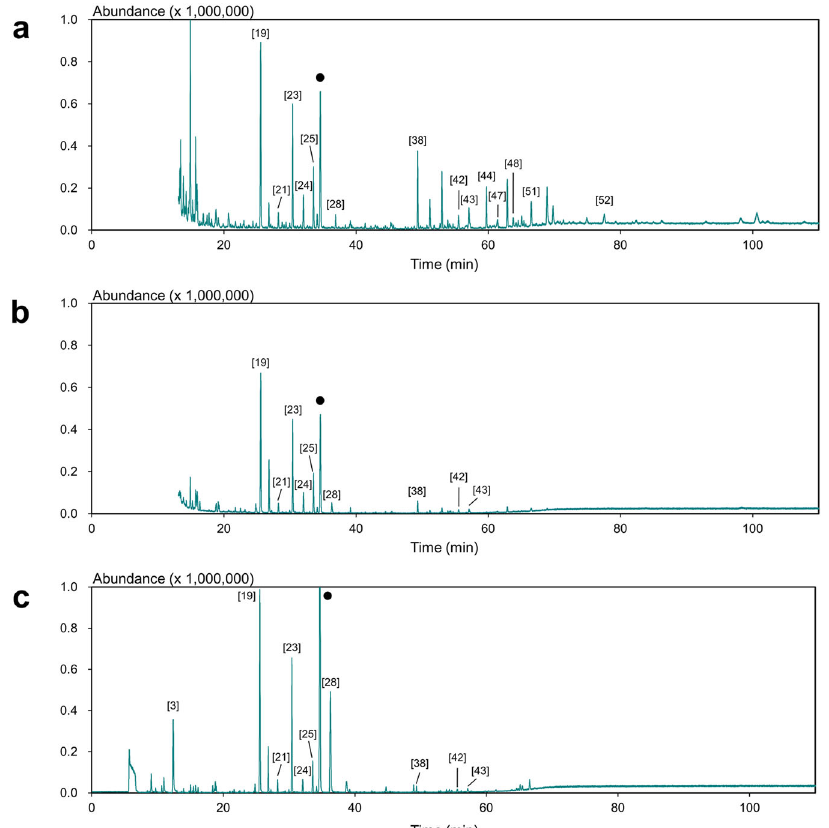
Fig. 2 GC – MS chromatograms of the EVOO extracts obtained using each extraction method. The chromatograms for OA-LLE + SAFE, SAFE, and head-space solid-phase micro extraction (HS-SPME) are shown in a – c , respectively. Numbers refer to the volatile compounds listed in Table 2. The closed black circles ( ● ) indicate the internal standard peaks